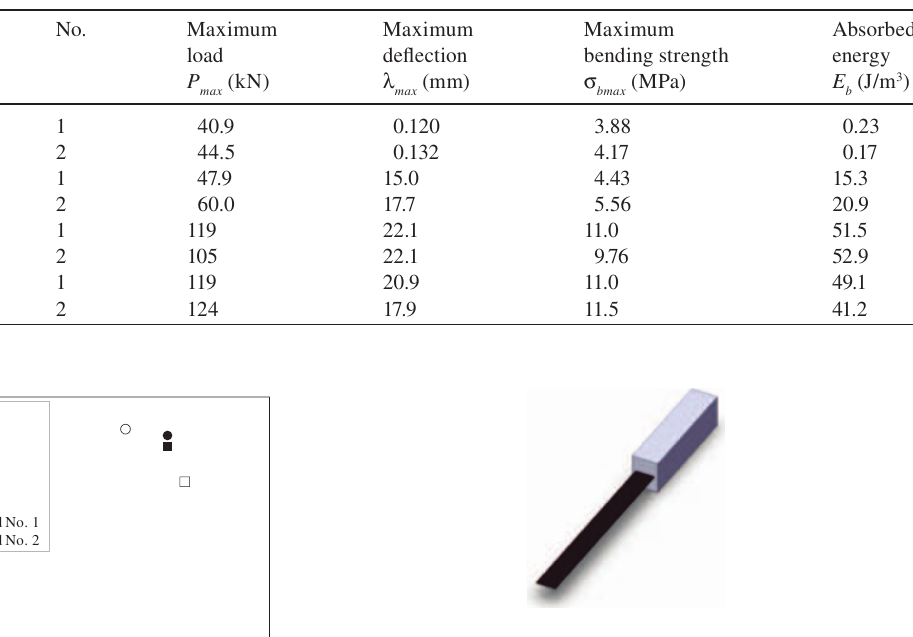
Figure 9 Specimen of pull-out test.